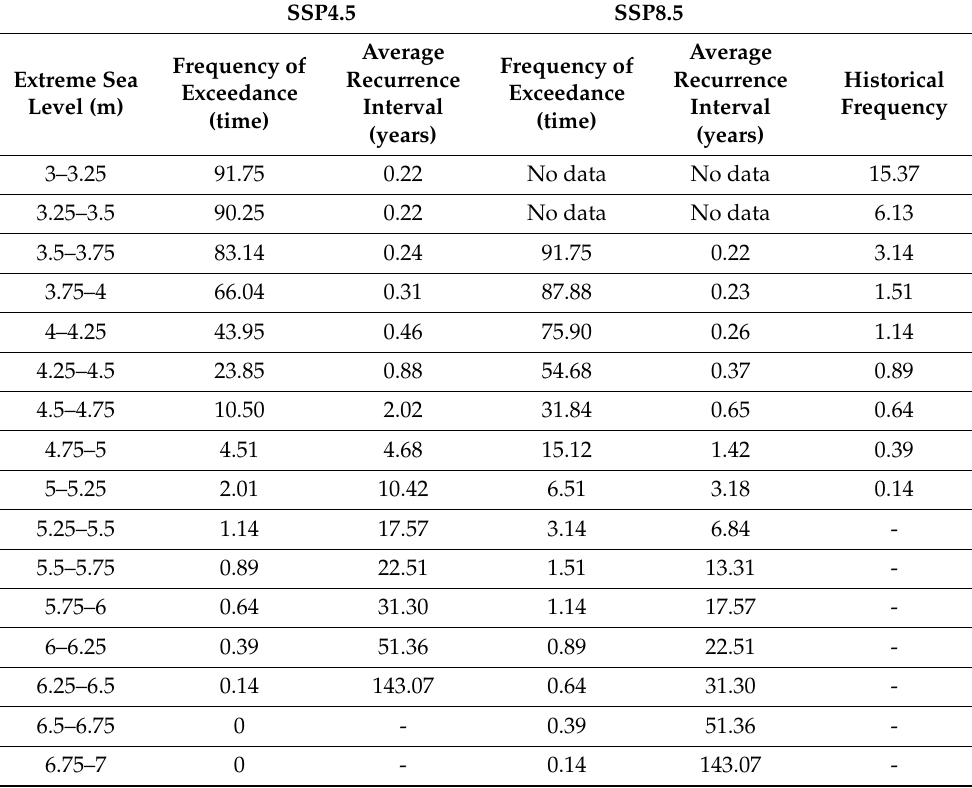
Table A3. Table of recurrence interval and frequency of exceedance for different levels of events.